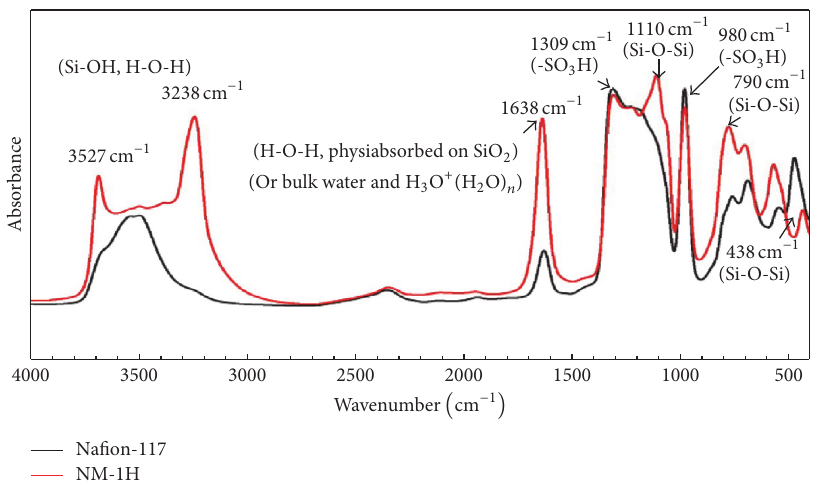
Figure 5: FT-IR spectra and for the pretreated N-117 and NM-1H modified membranes.